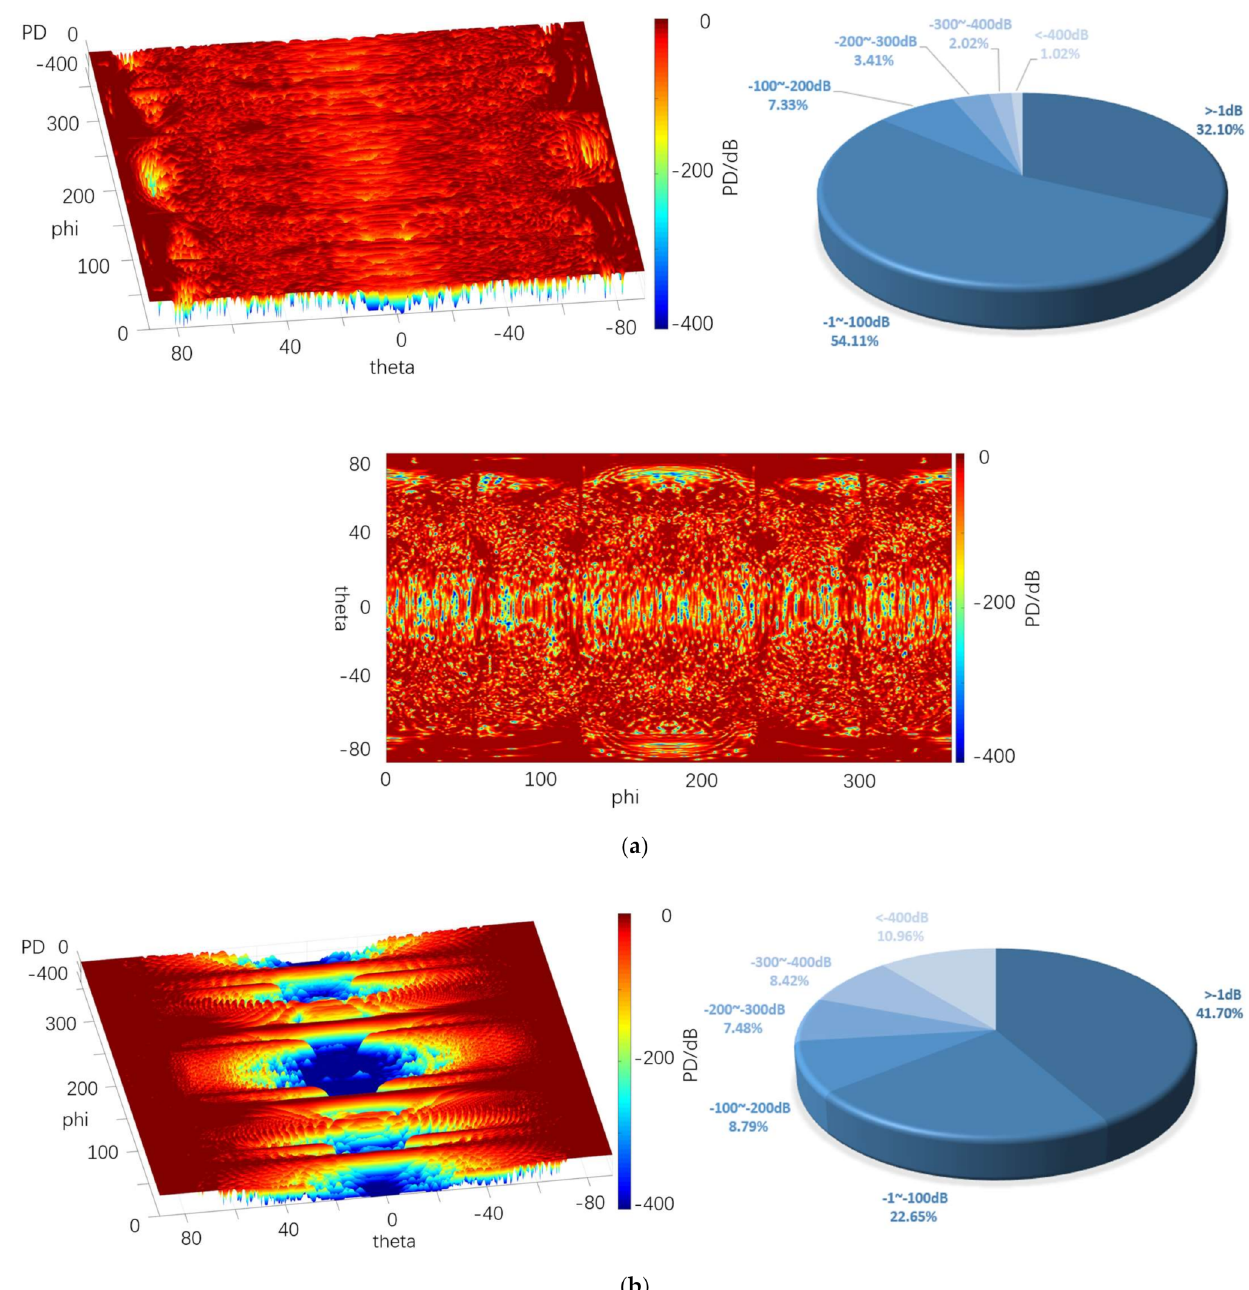
Figure 20. Probability distribution in the 4 π direction for 1000 km. ( a ) Quantum detection probability, ( b ) Probability of conventional